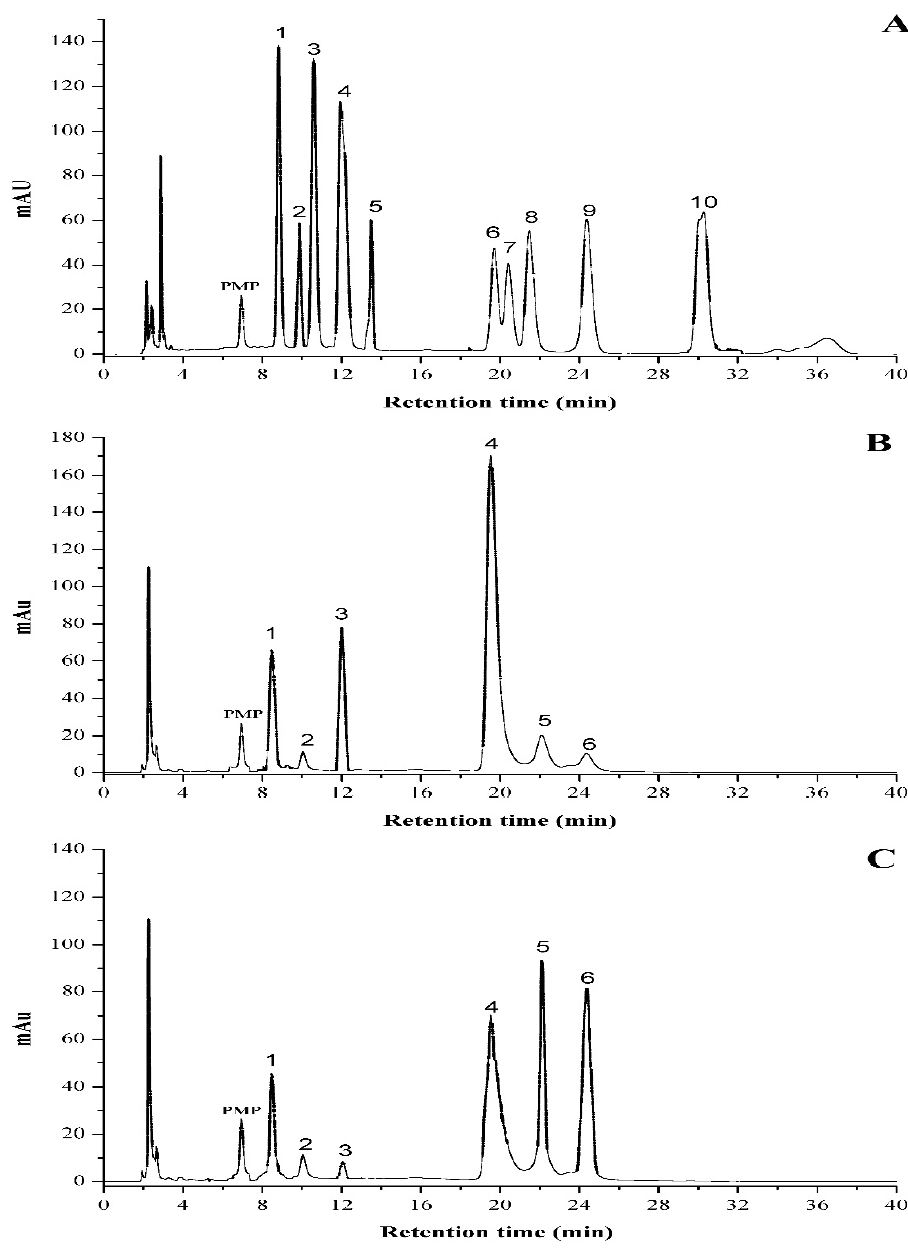
Figure 5. HPLC profiles of PMP derivatives of standard monosaccharides ( A ) PHPS-D and ( B ) PHPS-W. ( C ) Peaks: 1. mannose; 2. ribose; 3. rhamnose; 4. glucuronic acid; 5. galacturonic acid; 6. glucose; 7. xylose; 8. galactose; 9. arabinose; 10. fucose.